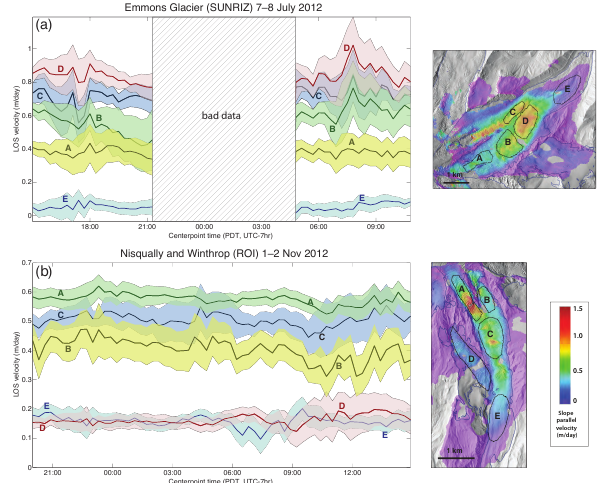
Figure 7. LOS velocity time series for areas outlined on maps to the right. Shaded region around each line represents ± 1 standard error for a 2-h running mean. (a) 24-h time series at SUNRIZ on 7–8 July 2012, gray box indicates the period with poor data quality (see text for details). (b) 22-h time series at ROI on 1–2 Novem- ber